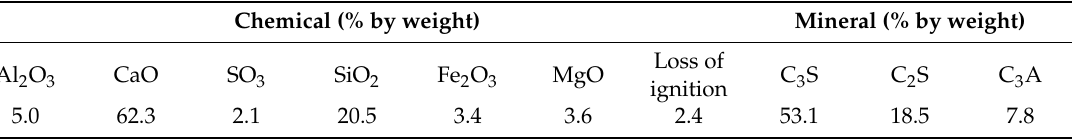
Table 1. Chemical and mineral compositions of ordinary Portland cement.